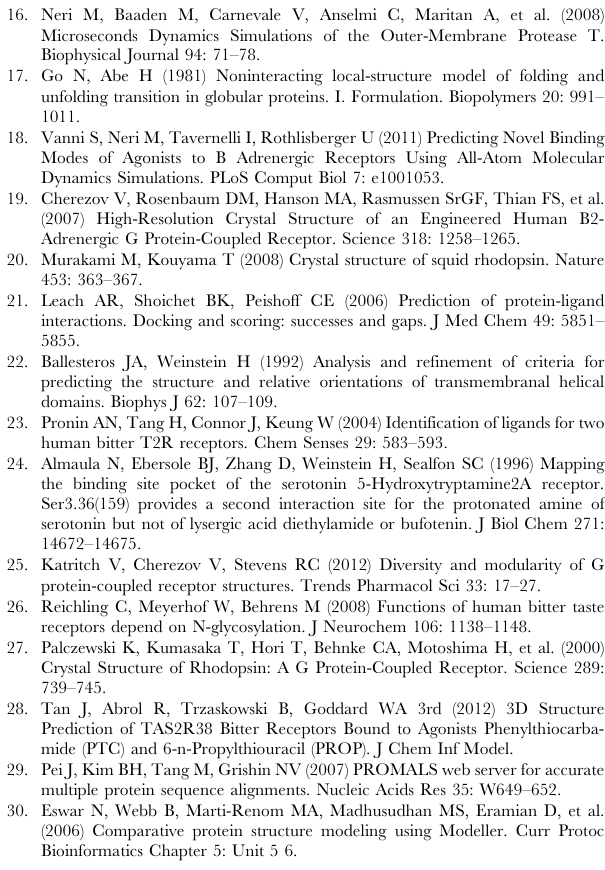
Figure S1 Alignment of the human bitter taste receptors sequences family. These were retrieved from the Uniprot database (http://www.uniprot.org/). The multiple sequence alignment was carried out using the program Promals [29]. Green columns correspond to the naturally polymorphic residues Pro49, Ala262 and Val296. Red columns comprise residues: Trp99, Met100, and Ser260. Blue columns indicate residues: Asn103, Phe197, Trp201, Ser259 and Phe264. Finally the grey region indicates the poorly conserved ECL2. Figure S2 Two independent MM/CG simulations were carried out for PTC/A, PTC/B, PROP/A and PROP/B. Here we plot the RMSD of the C a atoms of the four complexes as a function of time for both simulations (red and black continuous curves). Part of the ECL2 (residues 168 to 178) is very mobile in one of the simulations of PROP/ B , causing an increase of the RMSD values (continuous red curve). However, it does not interact at all with the agonist. The RMSDs of the protein excluding residues 168 to 178 is indeed not too dissimilar to that of the overall RMSD (dotted red line). Figure S3 Largest cavities of models A and B identified using Fpocket [ 42,43 ] . Figure S4 Location of three major naturally polymor- phic positions. Residues Ala262(blue), Val296(red) and Pro49(-